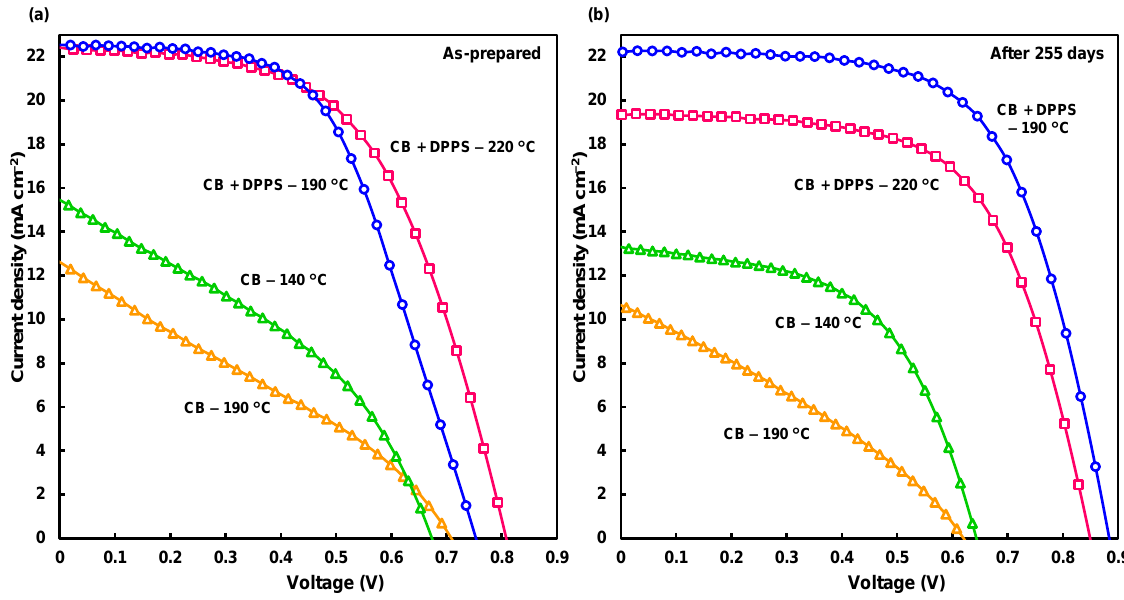
Figure 2. Current density voltage curves of the devices ( a ) as-prepared and ( b ) after 255 days in ambient air without encapsulation.